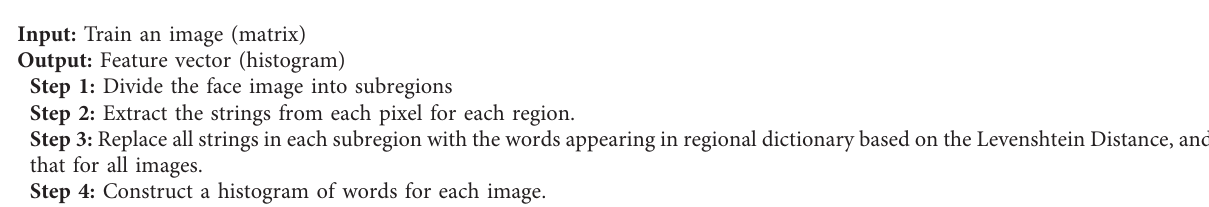
A LGORITHM 3: Extraction of the feature